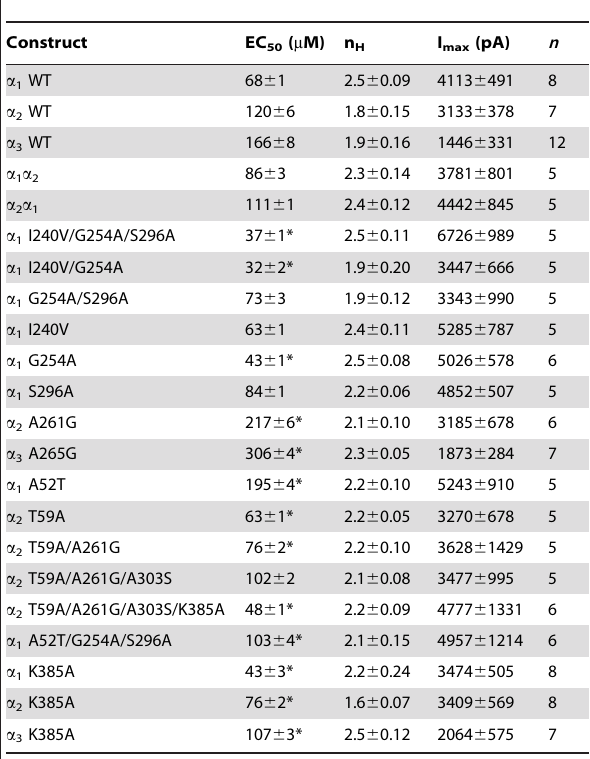
Values are indicated as mean 6 s.e.m. from the indicated number of cells. *indicates significant difference (P , 0.05, ANOVA) against the corresponding wild type GlyR subtype.